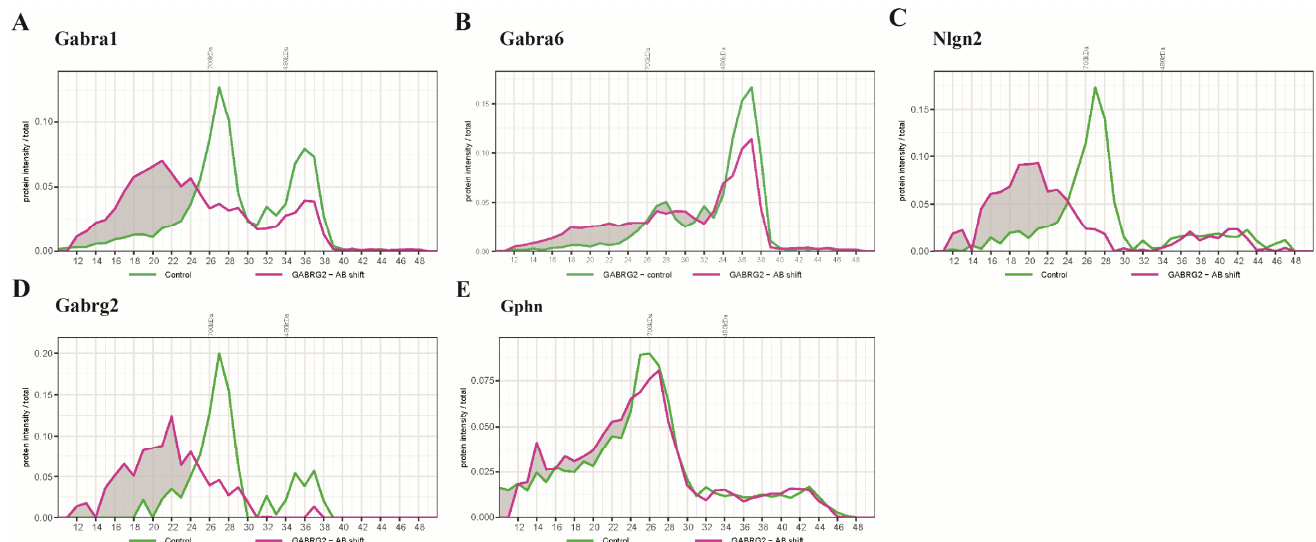
Figure 4. Protein profiles of selected proteins from an anti- γ 2 antibody shift experiment identified by mass spectrometry. ( A ) Pre-incubation of cerebellar extract with anti- γ 2 antibody shifted large proportion of α 1-containing complexes to higher masses in the BN. ( B ) The antibody shift slightly reduced the amount of an α 6-containing complex at 450 kDa, and caused the increase in the amount of a complex > 730 kDa. ( C ) The migration of a γ 2-containing complex at 680 kDa was accompanied by a shift of Nlgn2 toward higher masses. ( D ) Nearly all of the γ 2 subunits were up-shifted toward higher mass. ( E ) The anti- γ 2 antibody shift did not affect the migration pattern of Gphn.